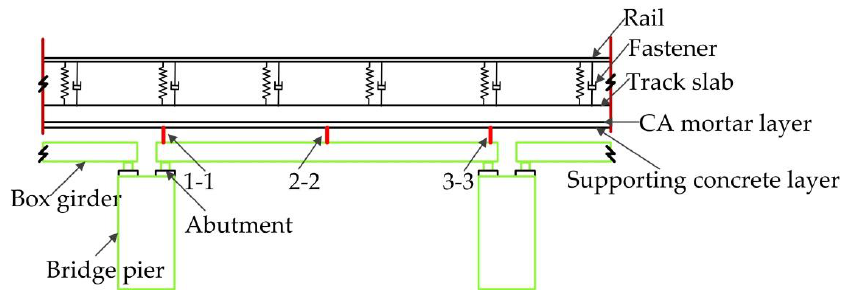
Figure 2. Longitudinal sketch of CRTS-II-slab ballastless track structure on the viaduct.